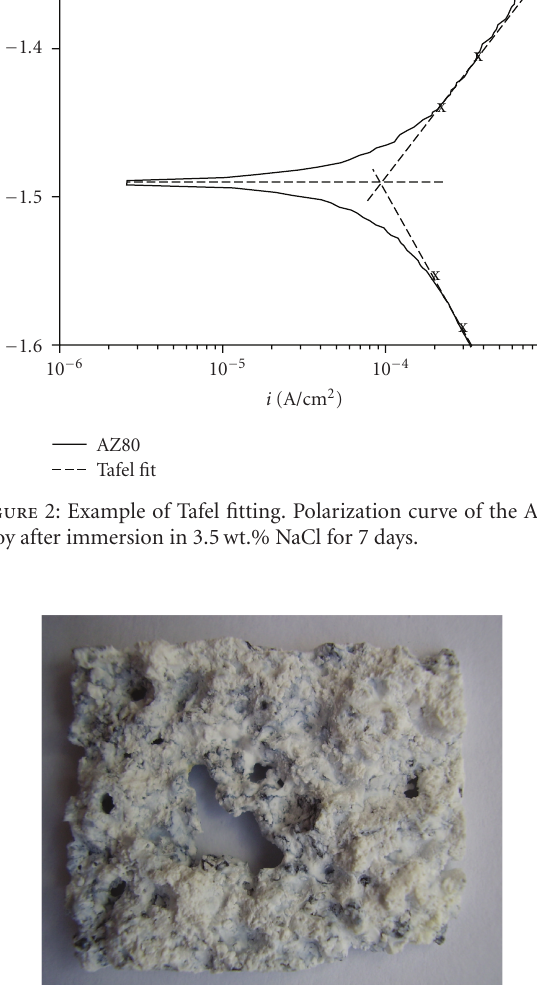
Figure 3: Uneven corrosion attack of pure Mg specimen after immersion in 3.5wt.% NaCl